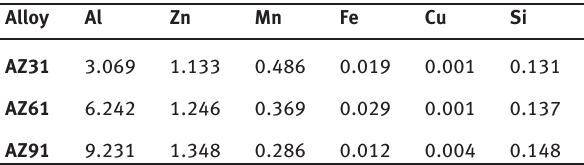
Table 1: Chemical compositions of the magnesium alloys used (% weight) (On the scale, no elements with a compounding ratio below 0.001% are given).